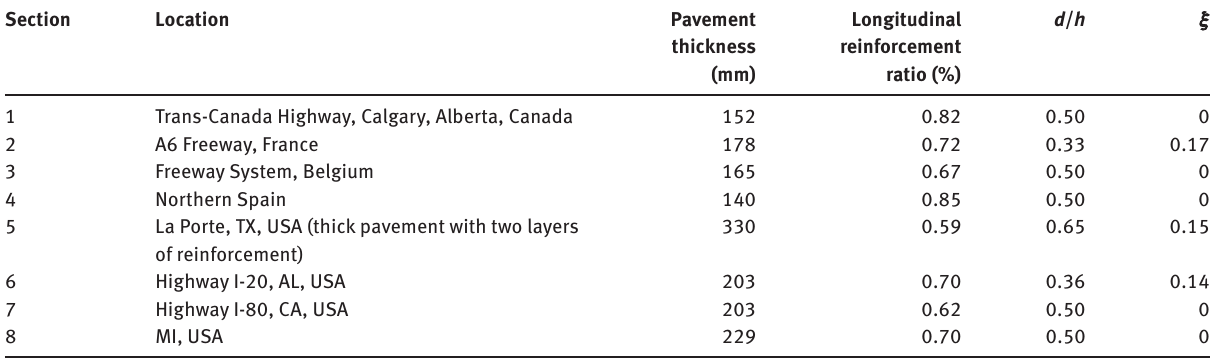
Table 1: Analyzed CRCP sections [1].